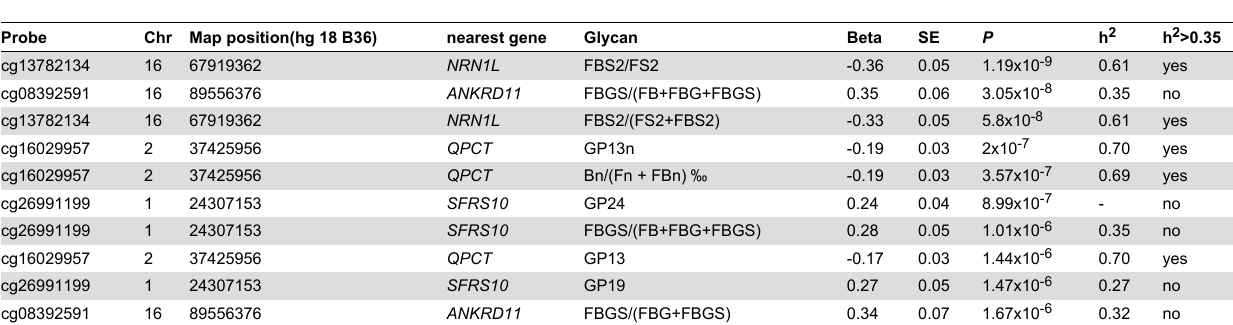
Table 3. Association between IgG levels and methylation probes ( P <2x10 -6 ).